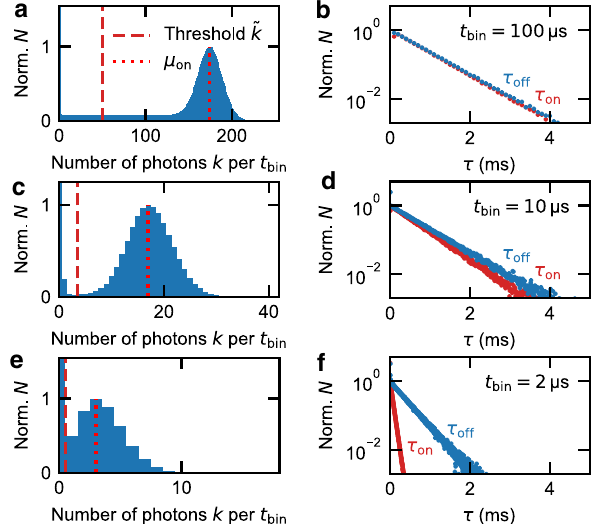
Figure 3. Histograms and waiting-time distributions for different t bin . ( a , c , e ) Histograms for t bin = 100 µ s , 10 µ s and 2 µ s , respectively. The histograms exhibit the on and off state distributions with a constant background. The choice of the threshold photon number ˜ k (red dashed) separates the on from the off state. ( b , d , f ) Corresponding waiting-time distributions. The time spans τ on and τ off show an exponential decay associated with the tunneling rate into and out of the quantum dot. For 100 µ s and 10 µ s the tunneling rates are very similar. For 2 µ s the rates differ strongly as increasingly more data points are assigned to the wrong QD state. The fitted rates in ( b ) are therefore most reliable with γ in ≈ ( 1.531 ± 0.014 ) ms − 1 and γ out ≈ ( 1.477 ± 0.010 ) ms − 1